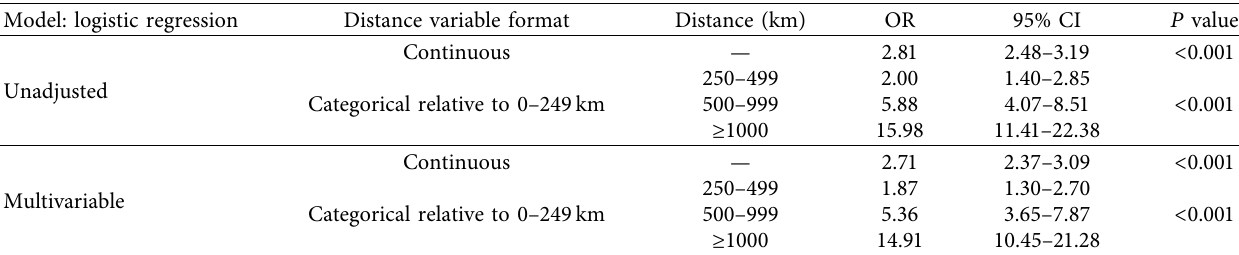
Table 2: Association between distance and risk of